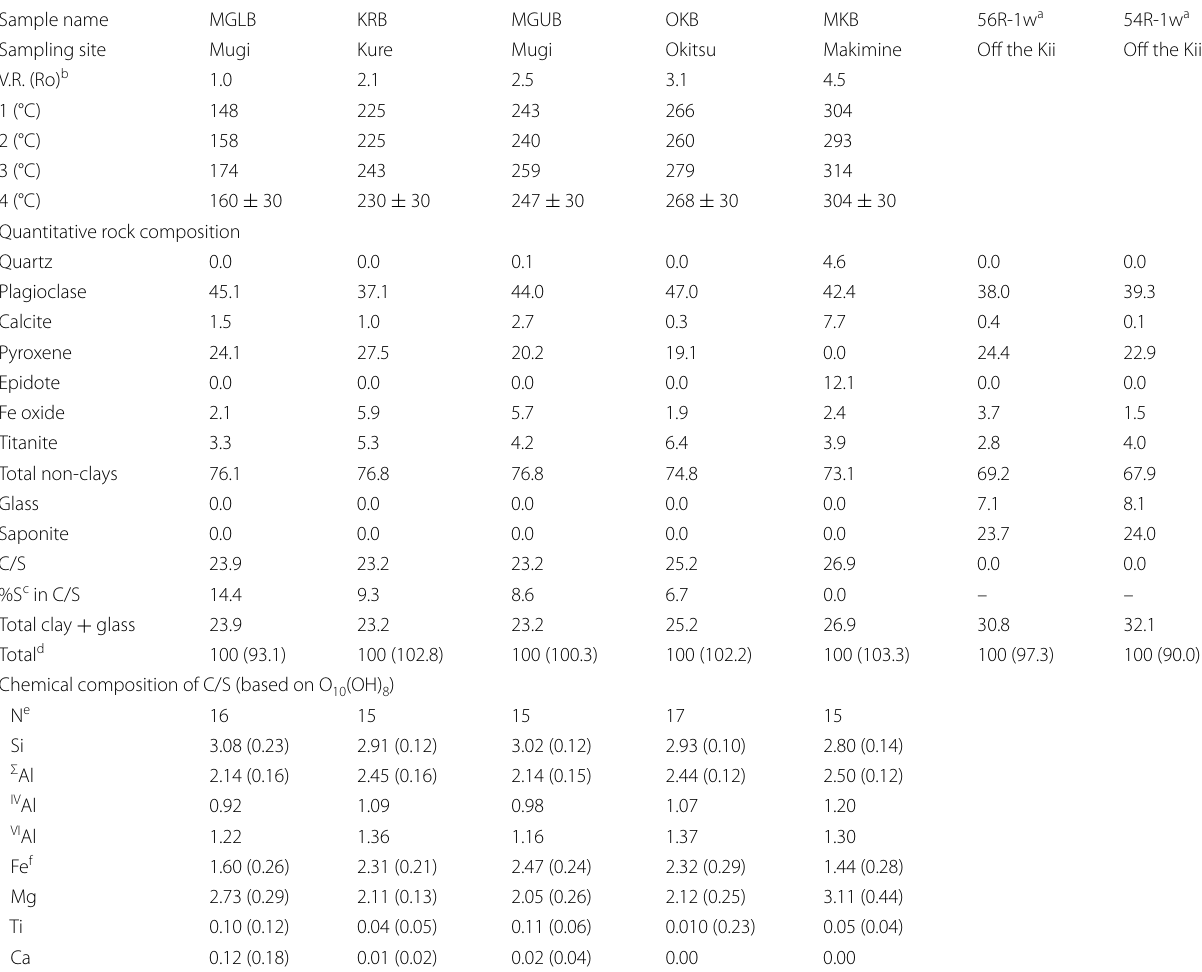
Table 1 Summary of the basalt samples analyzed during this